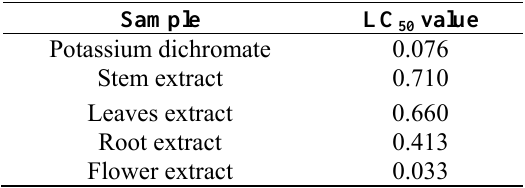
of methanolic extract of Euphorbia Table 3. LC 50